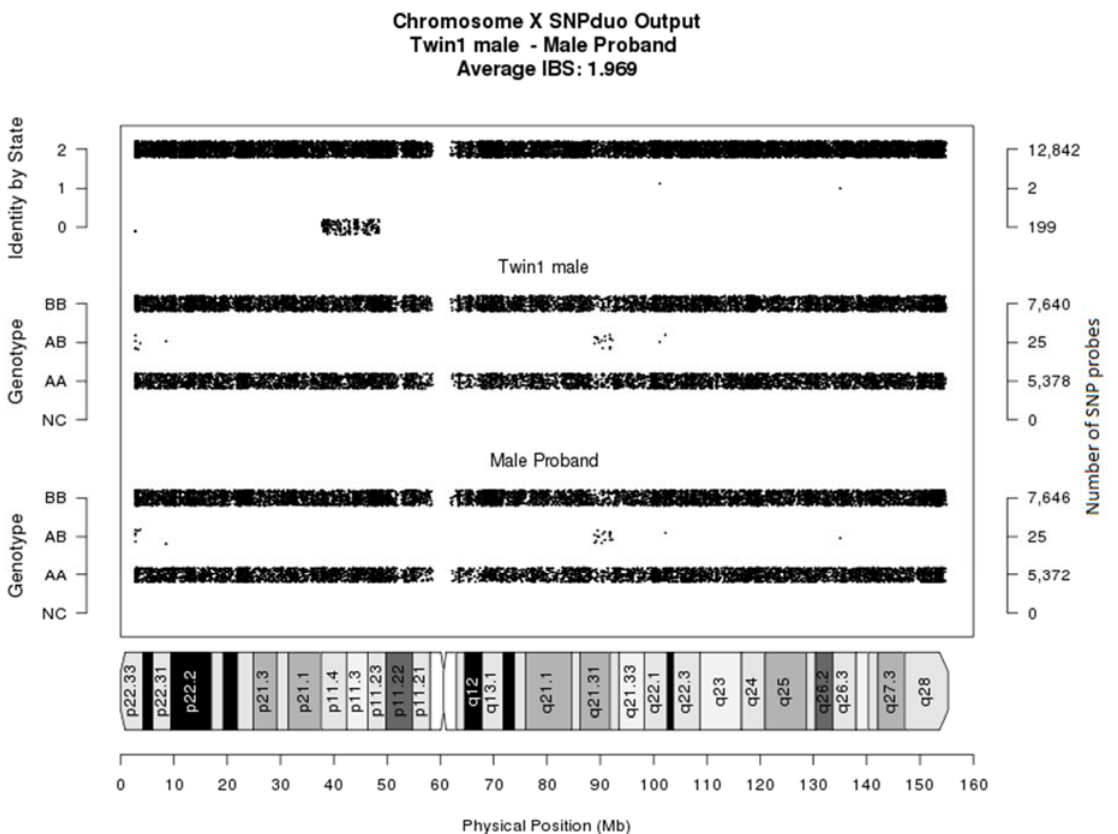
Figure 2. Chromosome X SNPduo comparison. A SNPduo comparative analysis of Illumina core exome single-nucleotide polymorphism (SNP) microarray genotyping data was performed using samples from Twin 1 (male) and the male proband. The output analysis showed that the two male siblings share identical alleles (identified by State 2) for chromosome regions Xpter (p11.4) and Xp11.23 (qter), including the FMR1 gene. This demonstrates the inheritance of the same X chromosome, with the exception of a small region of recombination (identified by State 0) for chromosome region Xp11.4 (p11.23).